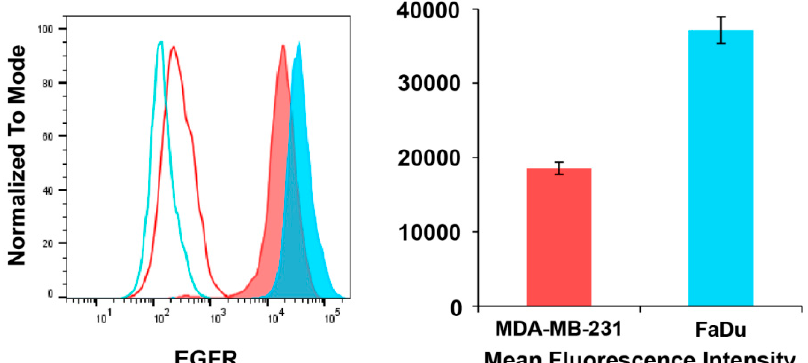
Figure 1. Quantification of epidermal growth-factor receptor (EGFR) expression on MDA-MB-231 (red) and FaDu (blue) cells by flow cytometry. Expression level of EGFR is shown by the filled histograms. Solid lines represent negative controls. Data are presented as mean ± SEM of two experiments performed in duplicate.